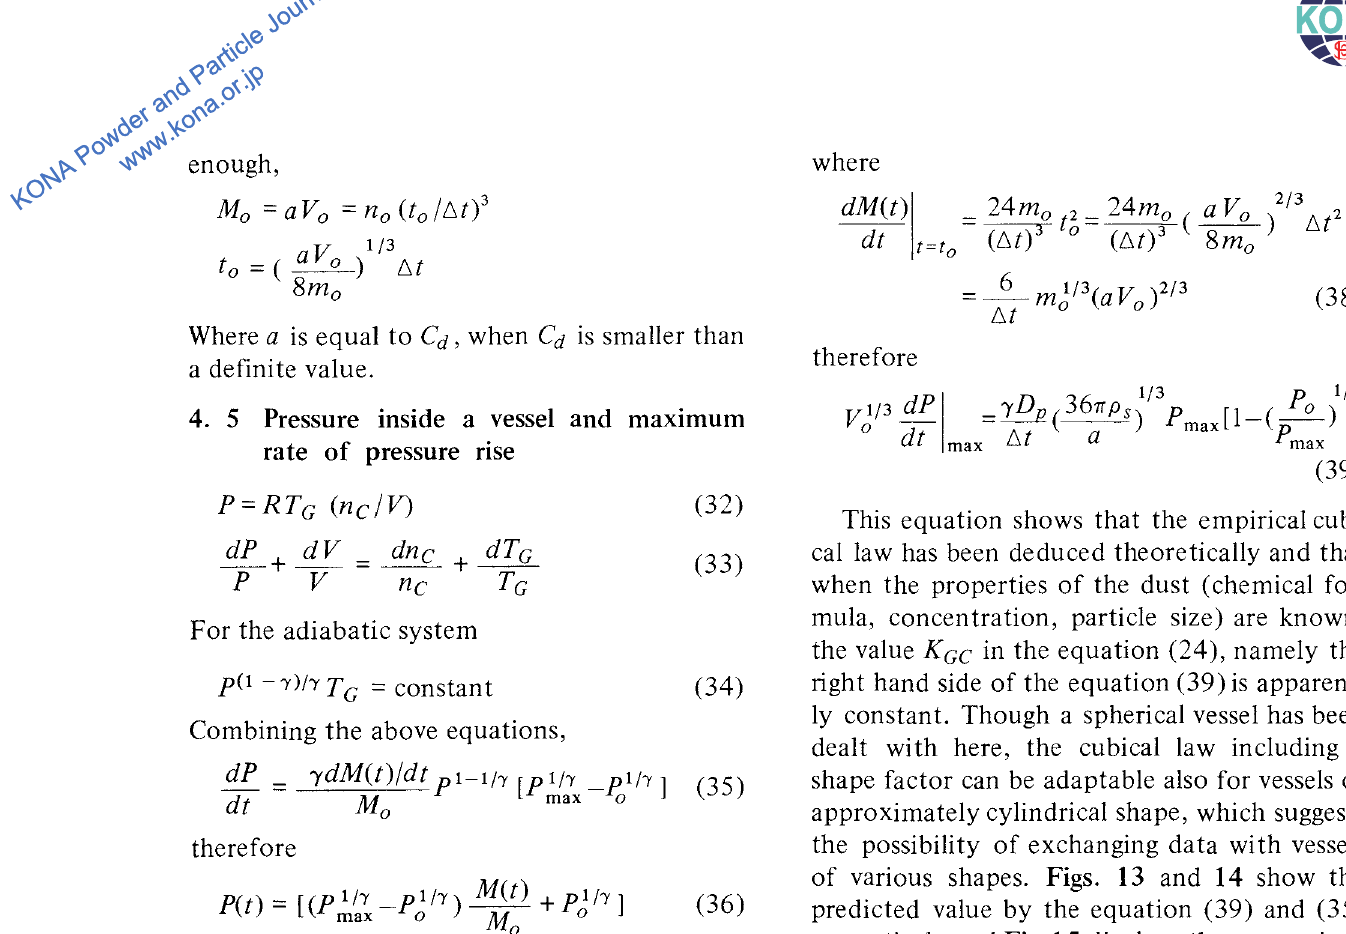
Fig. 13 Relation between K cc value and dust concentration